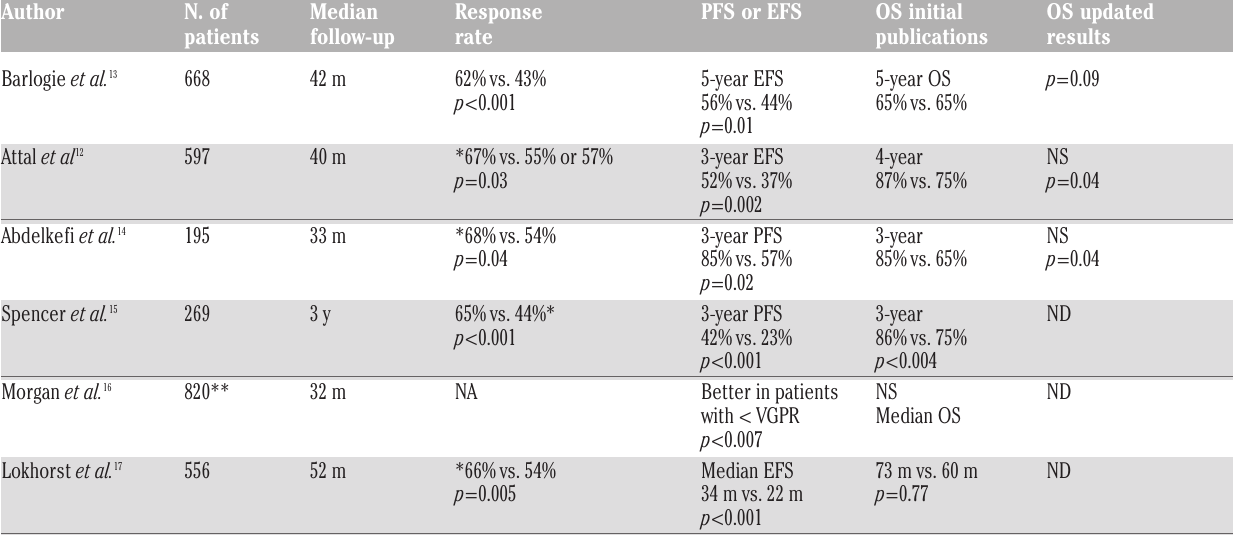
Table 2. Results of randomized studies on post-ASCT maintenance with